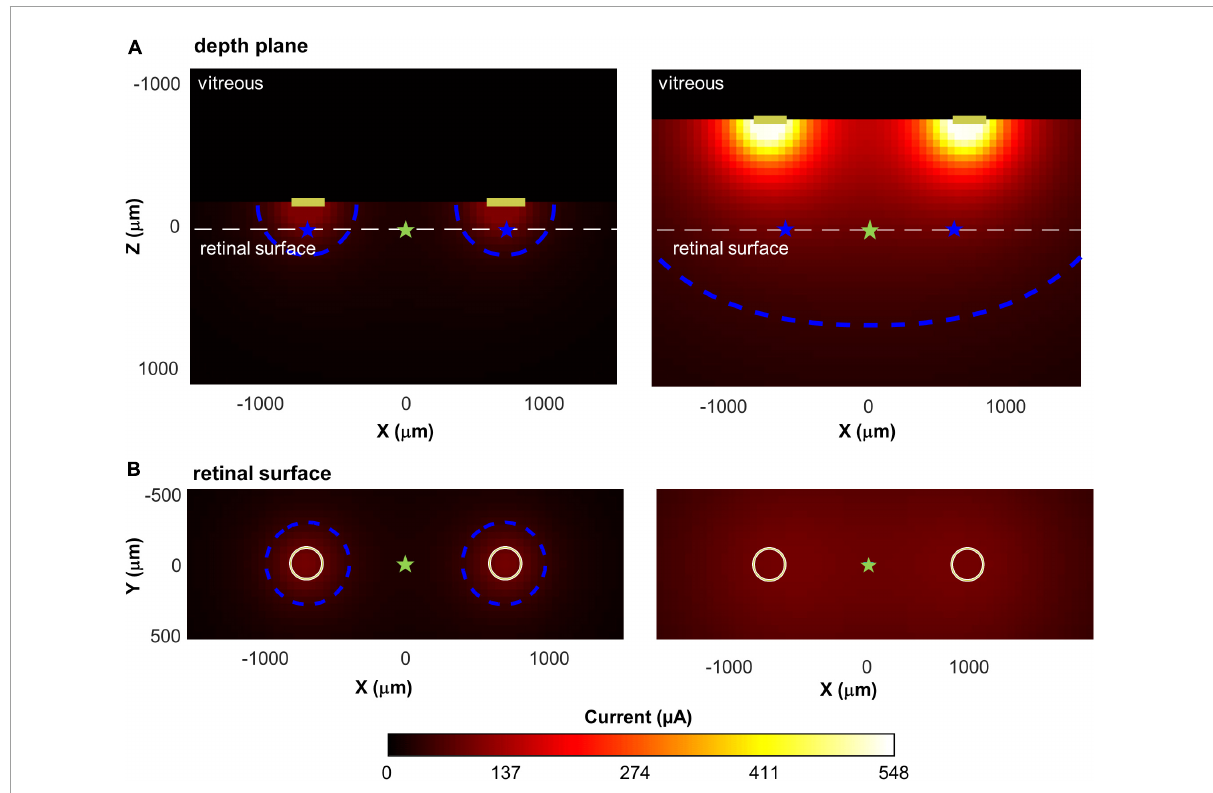
FIGURE9 Illustration of current spread for two pairs of disk electrodes, separated by 1,400 µ m, with different lifts from the retinal surface. Top: Cross-sectional view through the retina; Bottom: View of the retina from above. Current amplitude at the electrode was fixed to produce a maximum of 100 µ A of current on the retina. (A) Lifted 150 microns above the retinal surface. (B) Lifted 750 microns above the surface. The white dashed line in the upper panels shows the location of the retinal surface. Blue contour lines in each panel represent 50 µ A; cyan star: the intermediate point between the electrodes; blue star: the point of maximum current on the retinal